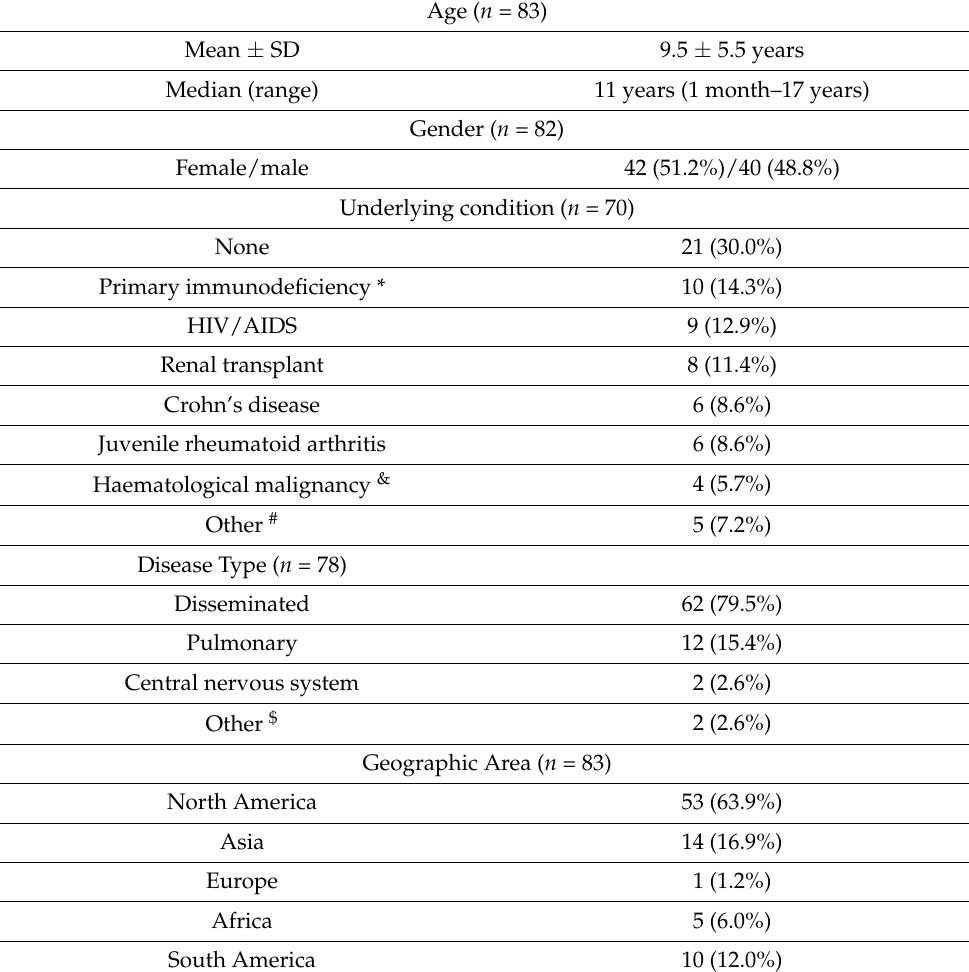
Table 2. Patient demographics and characteristics of 83 children with